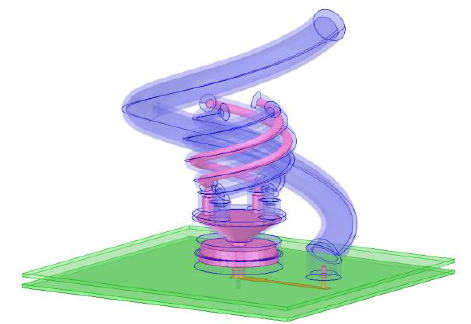
Figure 16. Diagram of State-III with liquid metal filled in.